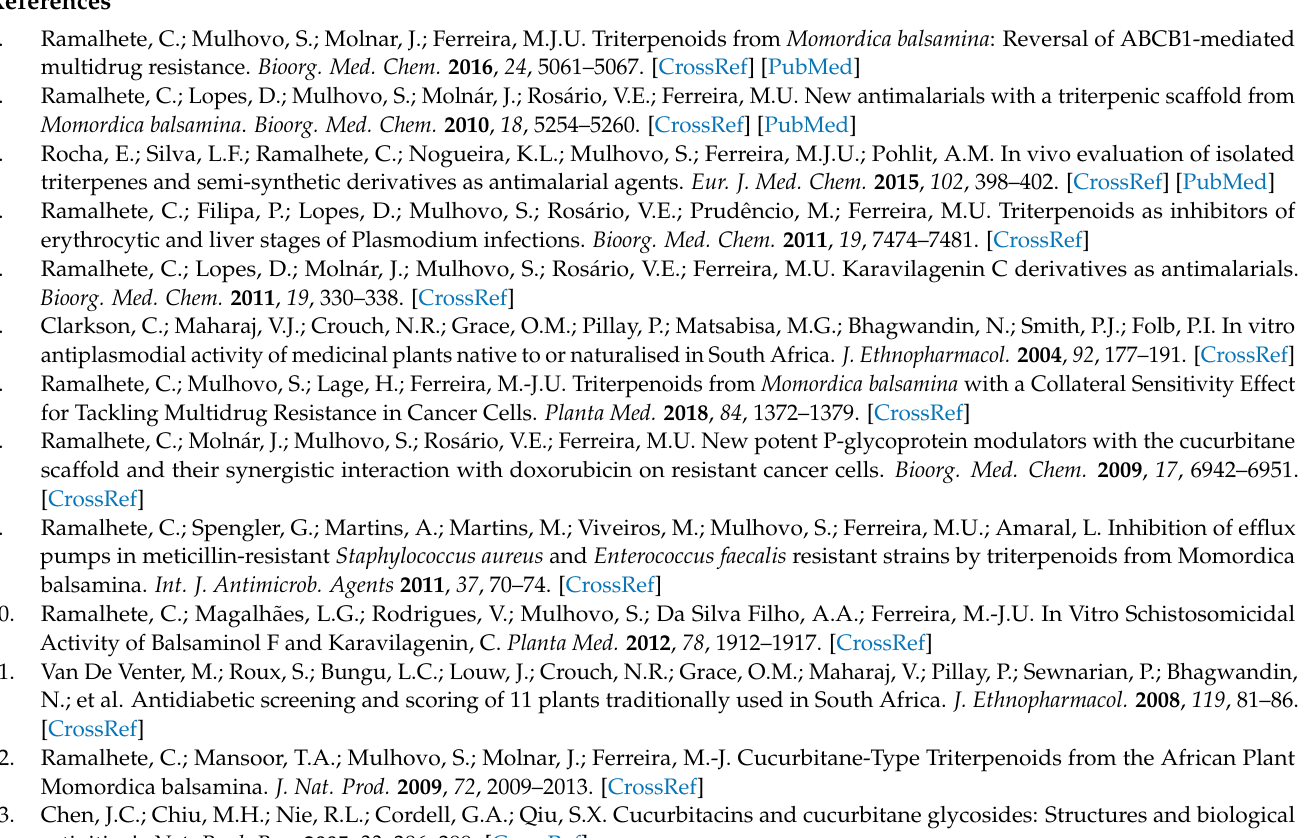
Figure S12 : Variable importance in projection (VIP)